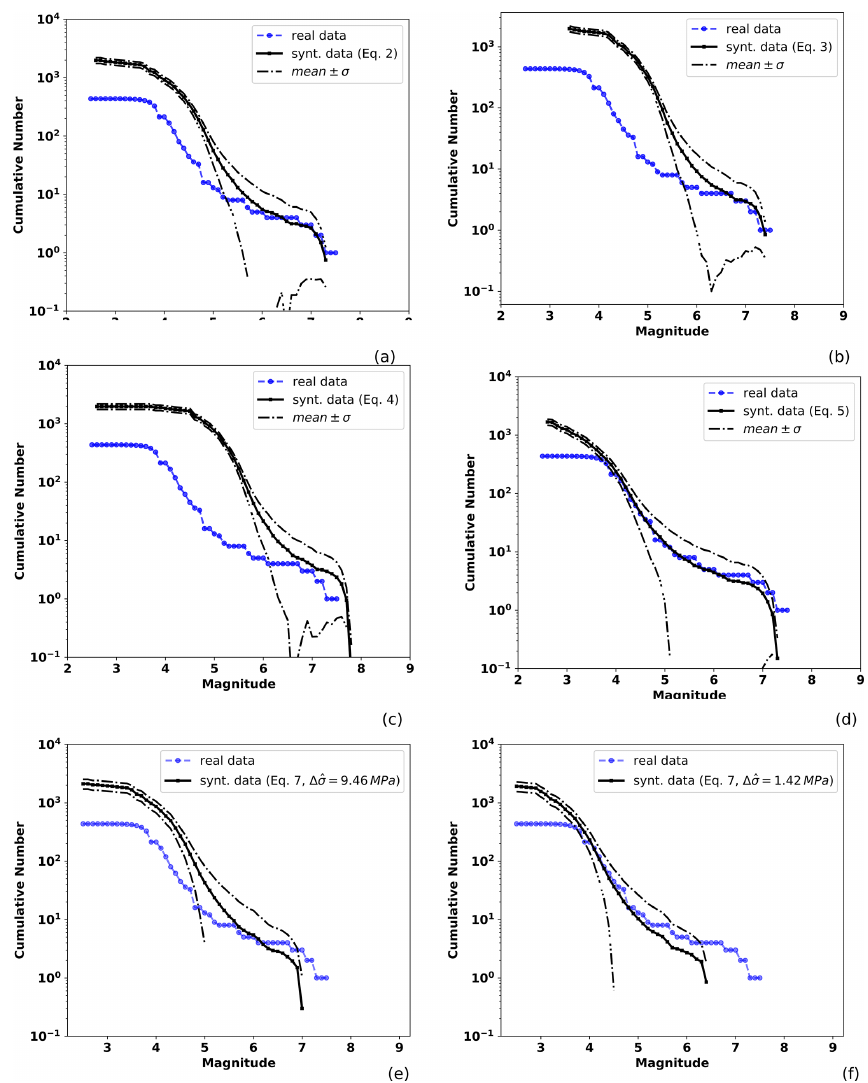
Figure 8. Observed and TREMOL synthetic frequency–magnitude curves for the aggregated frequency–magnitude curves computed with the contribution of the four mainshock ruptures. The solid black line is the mean of the synthetic results considering 80 realizations and the broken lines the standard deviation. The blue line is the seismicity curve for the events of Figs. 4, 5, 6, and 7. Each mean curve is obtained from one of the four magnitude–area relationships used in this study: (a) Eq. (3), (b) Eq. (4), (c) Eq. (5), (d) Eq. (6), and (e, f) Eq. (7) using the mean and median stress drop